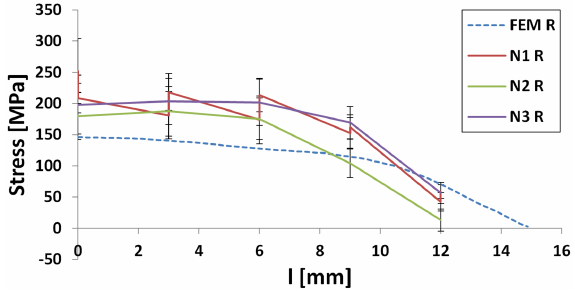
Figure 15. Radial stress—central